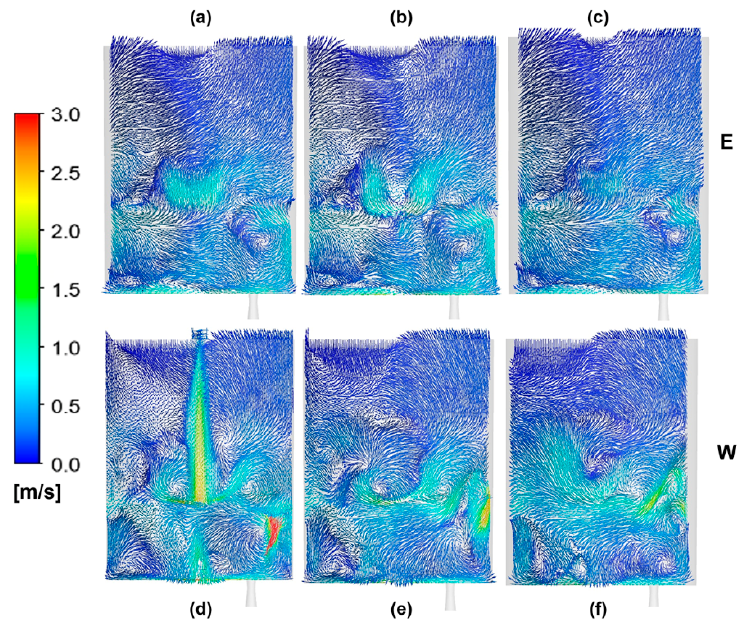
Figure 7. Velocity fields in planes East and West sectors at a bath level of 30 tons. ( a ), ( b ) and ( c ), correspond to the East sector, respectively. ( d ), ( e ) and ( f ), correspond to the West sector, respectively.